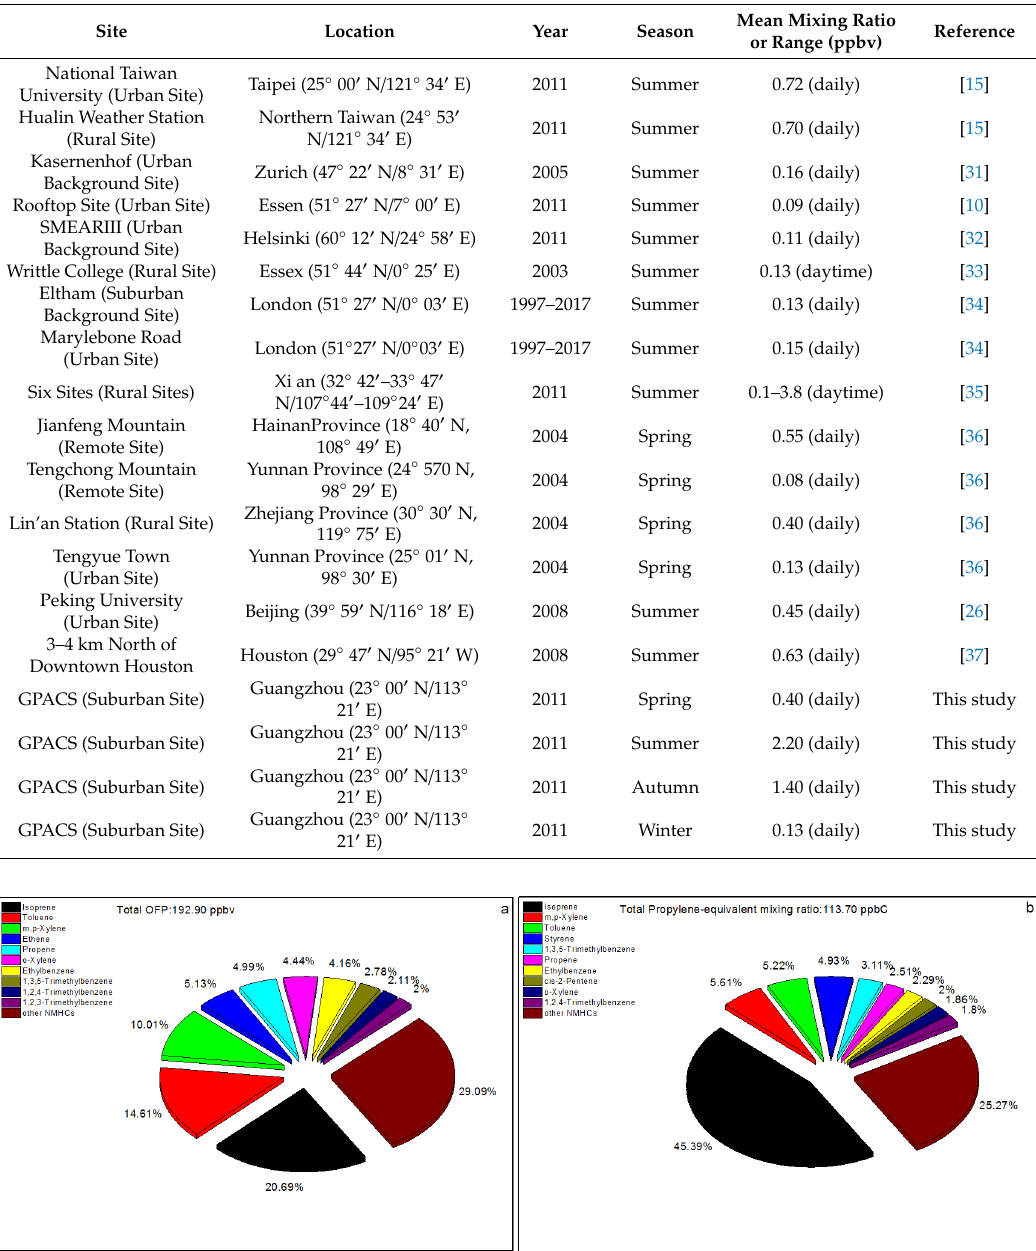
Table 3. Isoprene ambient mixing ratios measured at di ff erent locations in temperate and subtropical zones.